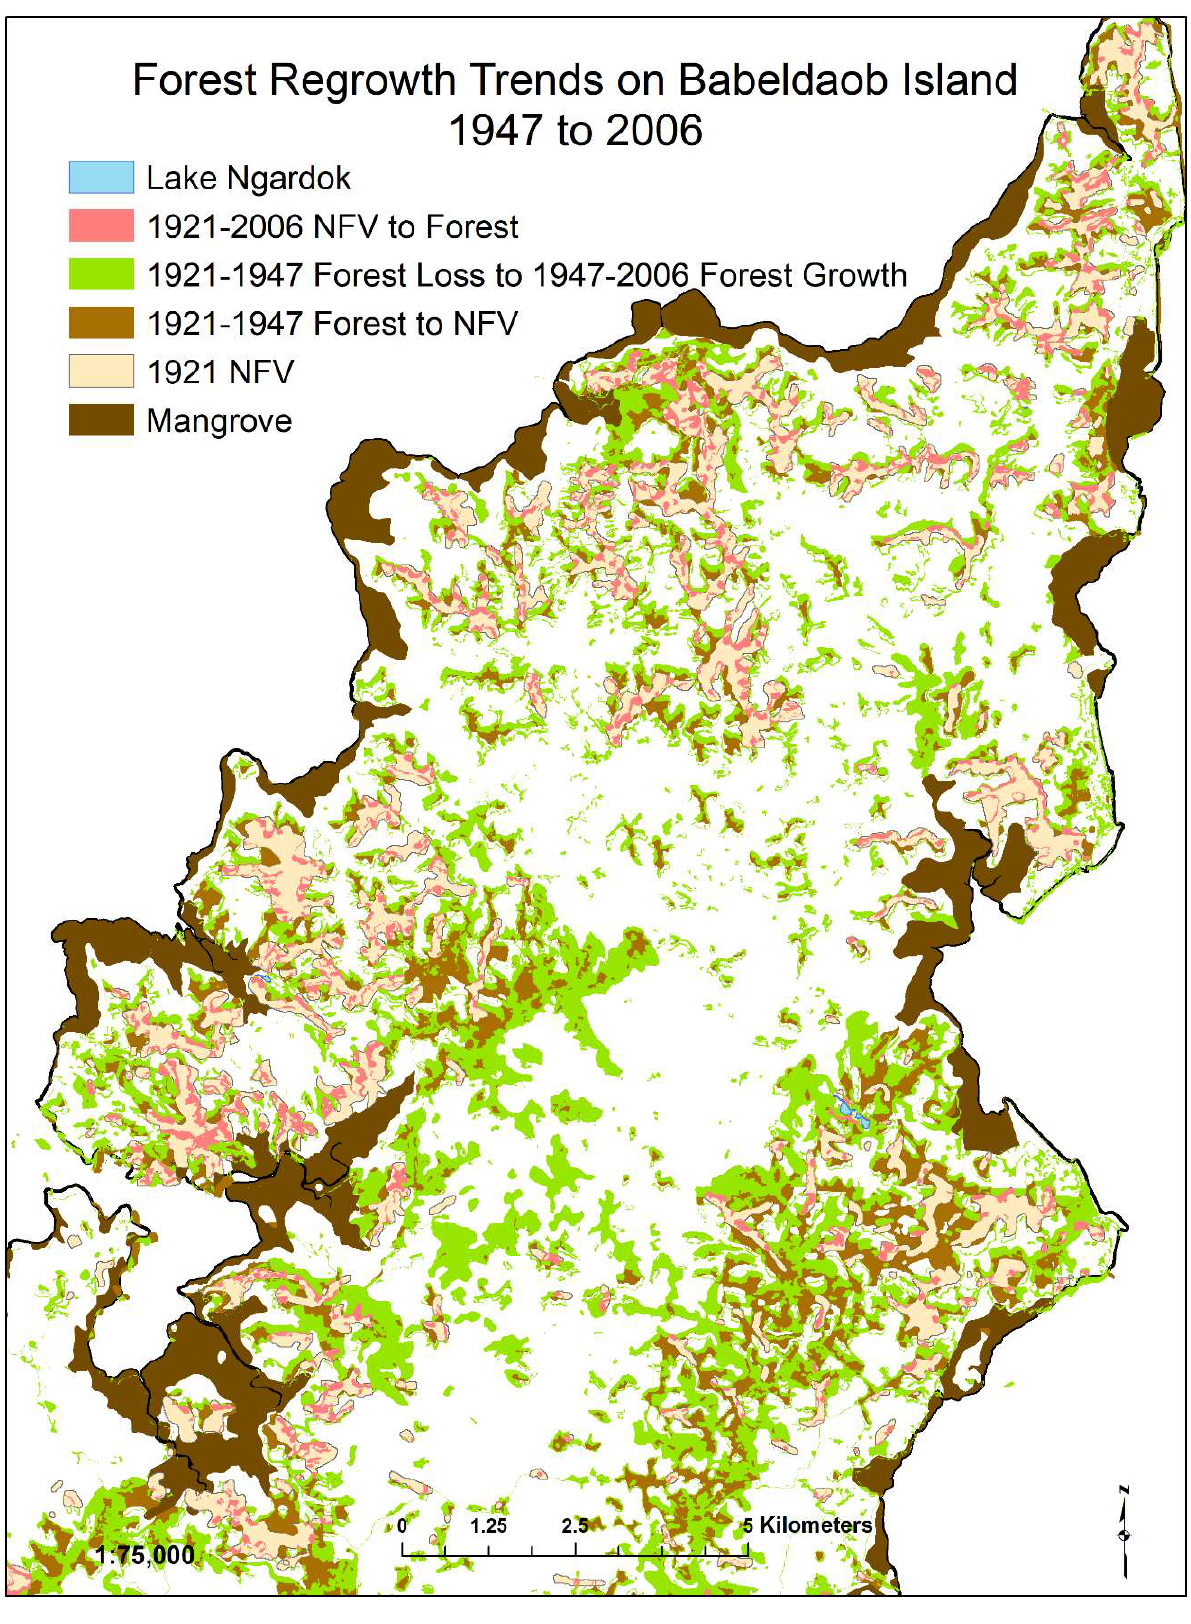
Figure 7. A 2× zoom view of north central Babeldaob Island, Palau showing forest growth from 1947 to 2006 in areas deforested between 1921 to 1947, and in areas of non-forest vegetation (NFV) in 1921.